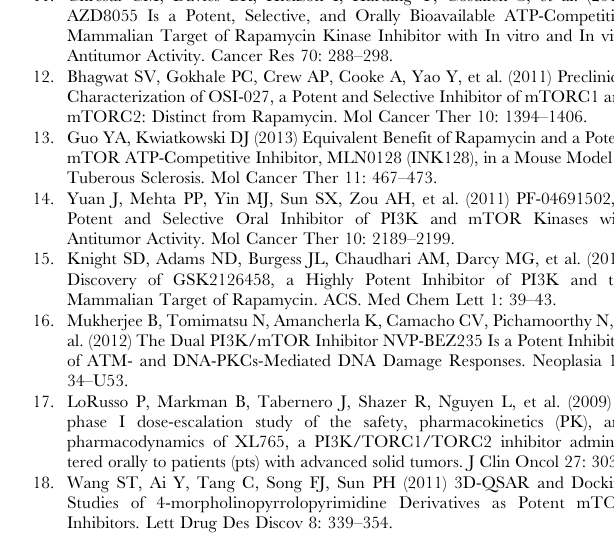
Figure S1 Distributions the sum of N plus O atom counts for mTOR inhibitors and non-inhibitors. Stu-